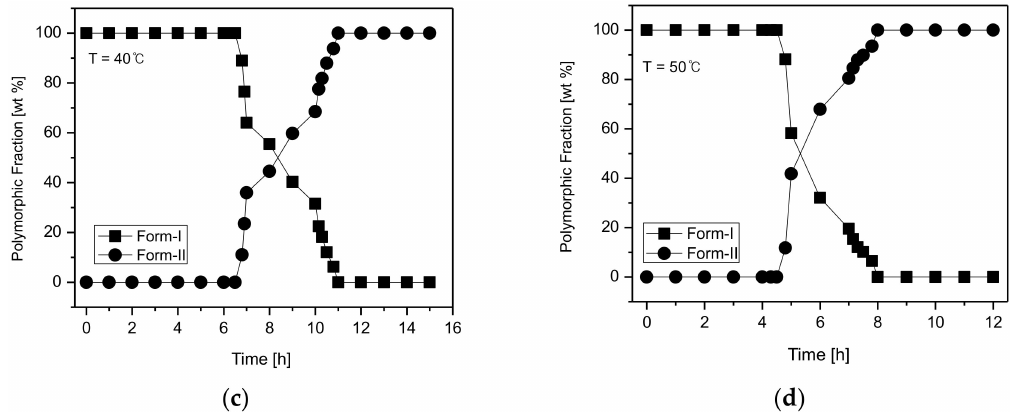
Figure 10. Profiles of the polymorphic fractions variation during the polymorphic transformation process of CO: ( a ) 20 ◦ C, ( b ) 30 ◦ C, ( c ) 40 ◦ C, ( d ) 50 ◦ C.